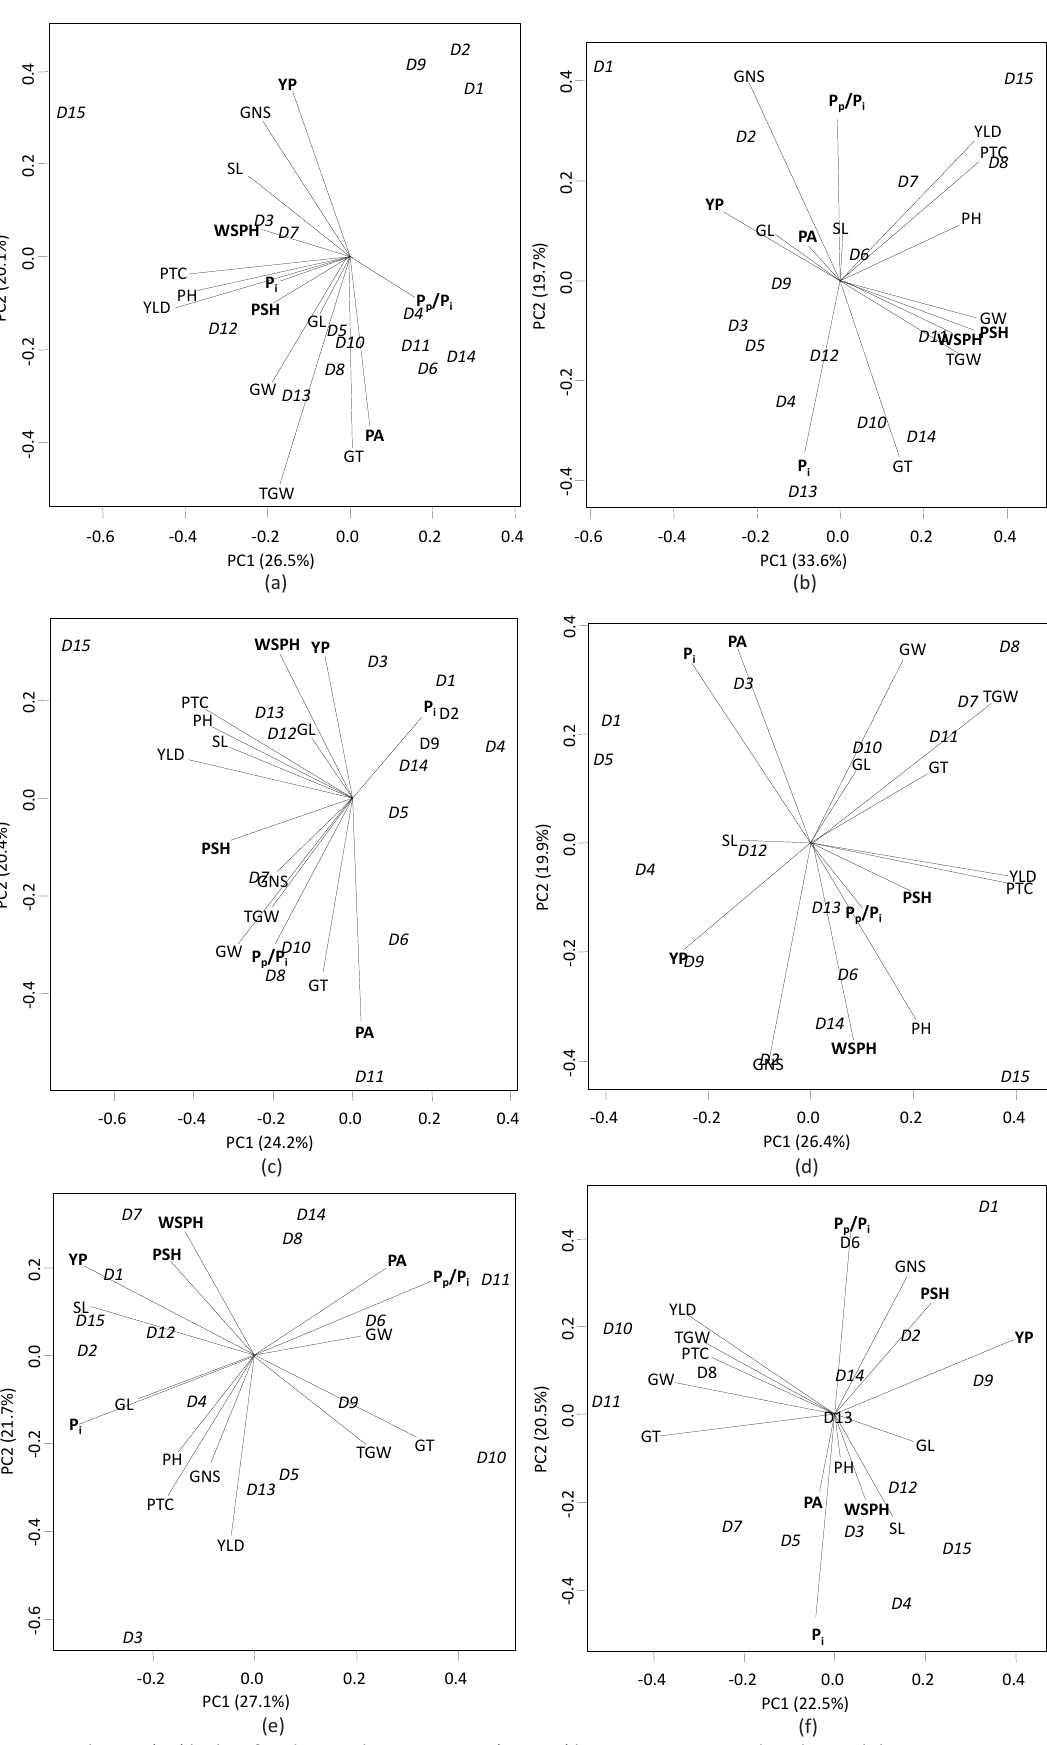
Fig. 2. Genotype by trait (GT) biplot of 15 durum wheat genotypes ( D 1- D 15) by nine agronomic and six chemical characteristics, measured across six environments (Rimski Šančevi for 2010-2011 (a) and 2011 – 2012 (b) vegetation season, Zemun Polje for 2010 – 2011 (c) and 2011 – 2012 (d) vegetation season and Padinska Skela for 2010–2011 (e) and 2011 – 2012 (f) vegetation season). YLD = grain yield; TGW = thousand grain weight; PH = plant height; SL = spike length; GNS = grain number per spike; GL = grain length; GW = grain width; GT